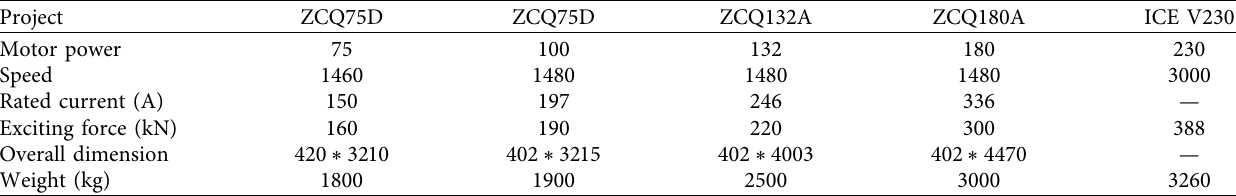
Table 1: Main technical parameters of vibroflotation device.